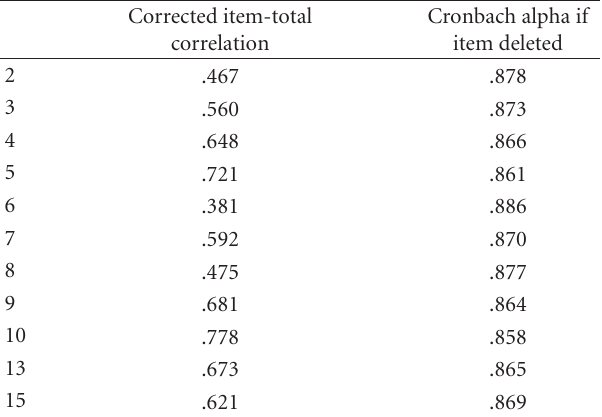
Table 4: Discriminatory power and Cronbach α for each item (first